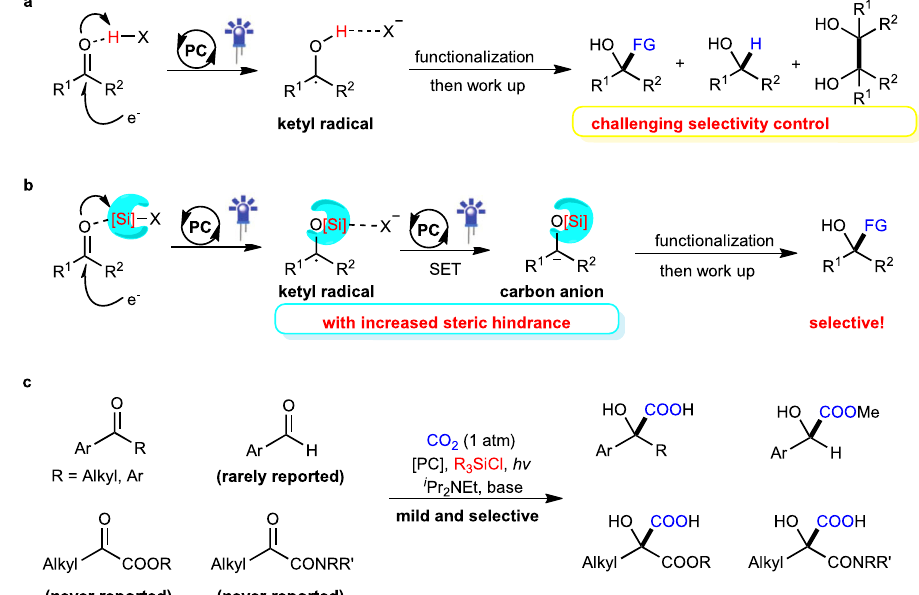
Fig. 1 Strategies for umpolung functionalization of carbonyl compounds via photocatalysis. a Previous strategy: proton-coupled electron transfer via photocatalysis. b Our design: chlorosilane-coupled electron transfer via photocatalysis. c This work: a general umpolung carboxylation of carbonyls via photocatalysis. FG functional groups, PC